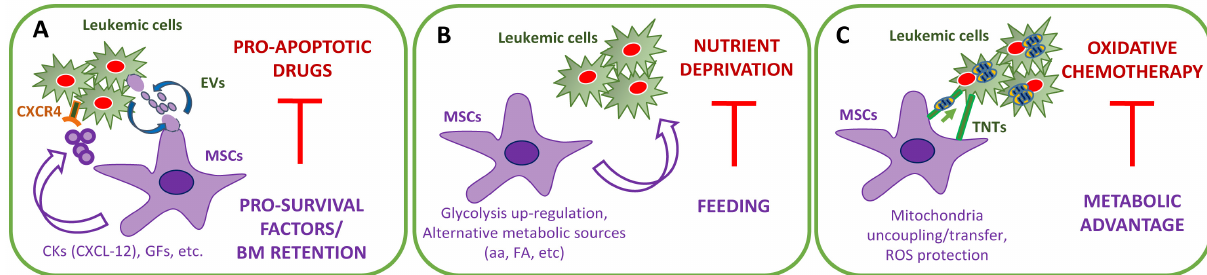
Figure 1. MSC-dependent mechanisms of resistance to therapy. Mesenchymal stromal cells (MSCs) support leukemic cells in diverse ways (purple): ( A ) supplying pro-survival factors (directly, mediated by extra-vesicle EVs or depending on BM retention), ( B ) providing metabolic substrates alternative to glucose, ( C ) rewiring metabolism. Each of these mechanisms interferes with a different therapeutic strategy (red). CKs, cytokines; GFs, growth factors; aa, amino acids; FA, Fatty acids; TNT, tunneling nanotubes; ROS, reactive oxygen species.